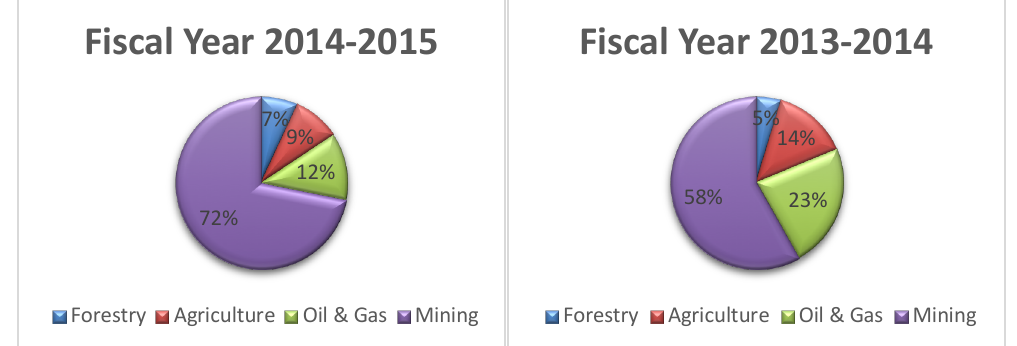
Figure 3 : Sector comparison for two fiscal years in